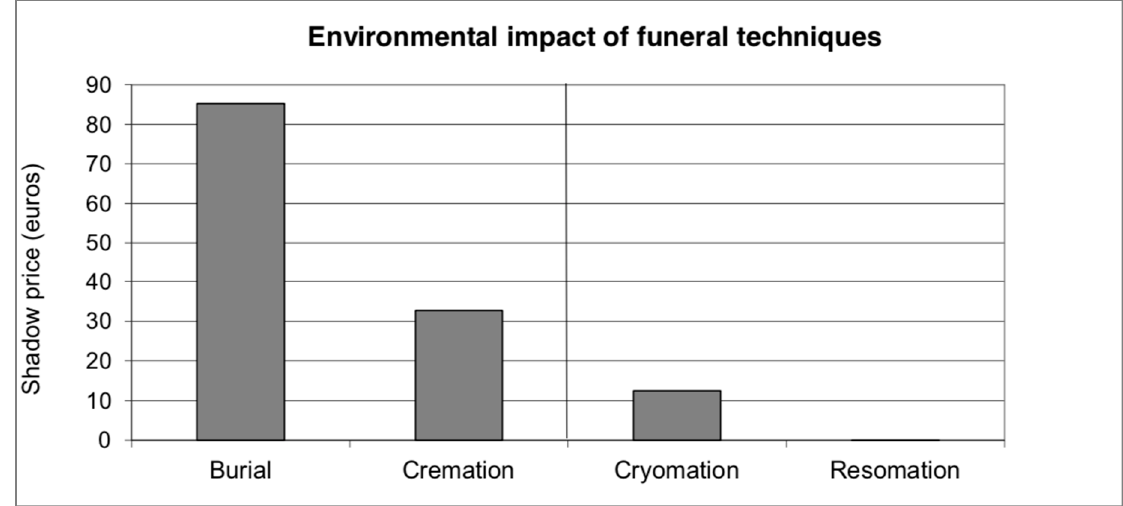
Figure 2. Information graphic depicting the environmental impact of funeral techniques (Keijzer and Kok 2011).